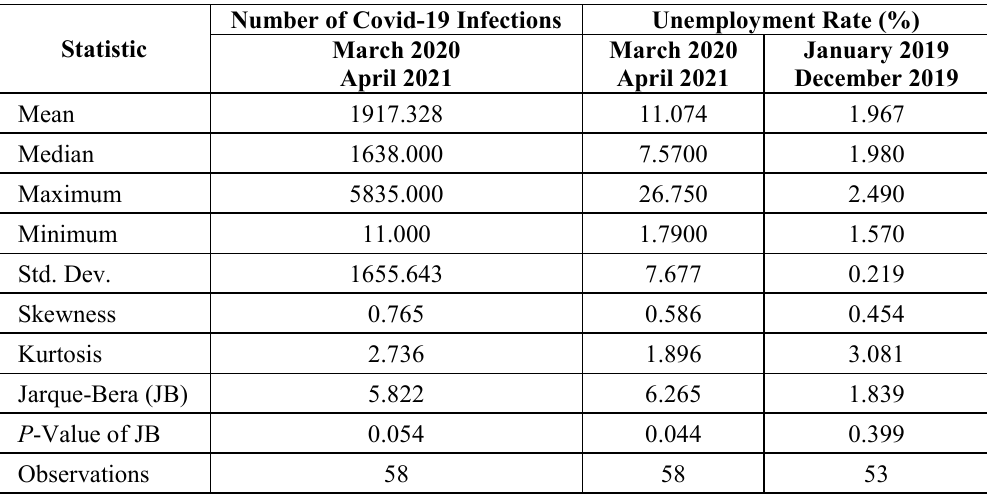
Table 1. Descriptive Statistics of the Series ( Weekly